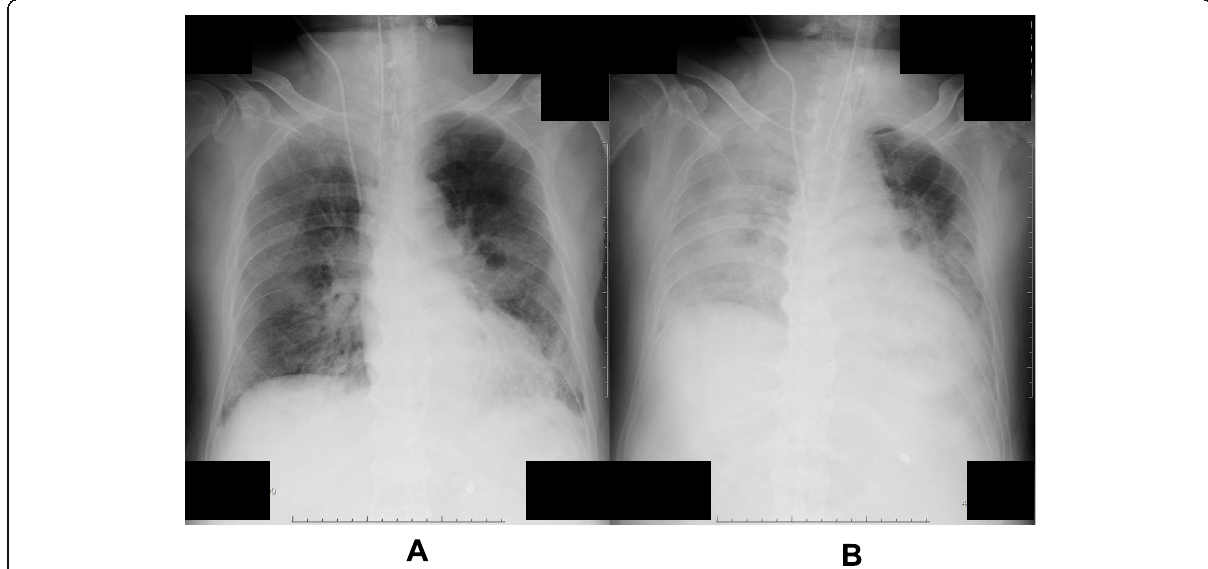
Fig. 2 a Suspected ventilator-associated pneumonia (VAP). Two days after completion of prone positioning therapy (4 days after